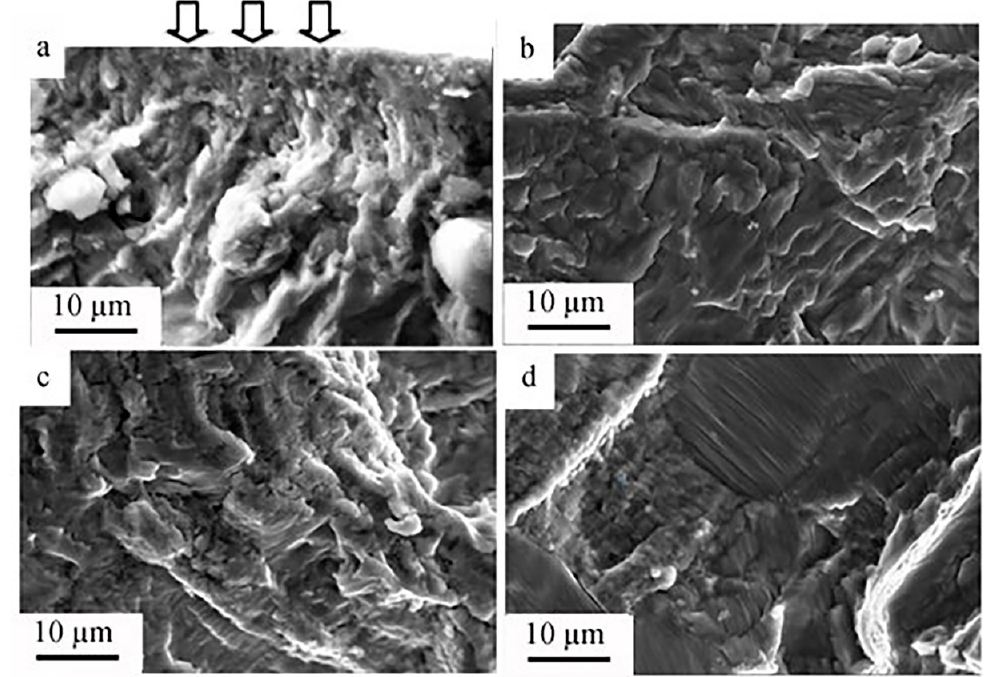
Figure 7. Block (subgrain) structure formed in the surface layer of titanium destroyed during the fatigue tests in the magnetic field: ( a ) 0 T; ( b ) 0.3 T; ( c ) 0.4 T; ( d ) 0.5 T. The arrows in ( a ) indicates the surface of the sample.